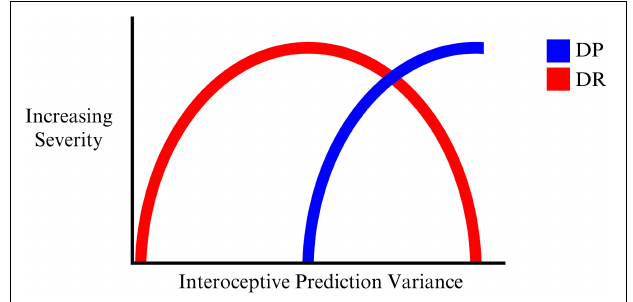
FIGURE 1 | The progression of DR, mixed DP/DR, and DP with increasing variance (decreasing precision) of interoceptive